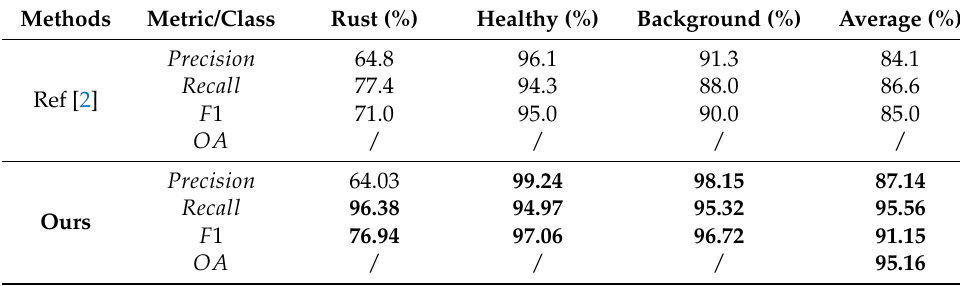
Table 7. Performance with inputs C.